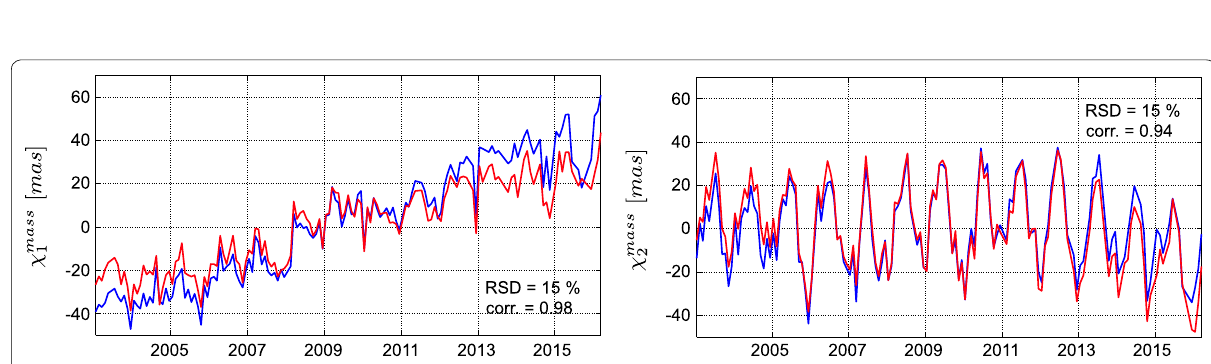
Fig. 4 Comparison of the equatorial effective angular momentum functions χ mass 1 and χ mass 2 computed from CSR RL05 (blue) and CSR RL06 (red) (mean values of the time series are removed). The corresponding correlation coefficients and relative standard deviations (RSD) are